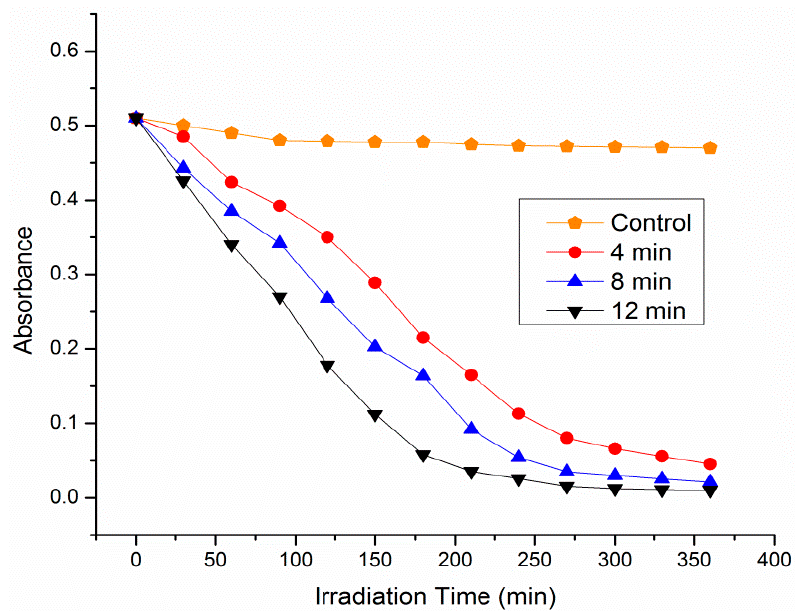
Figure 9. Solution discoloration activity of the ZnO-nanorod-coated fabrics.